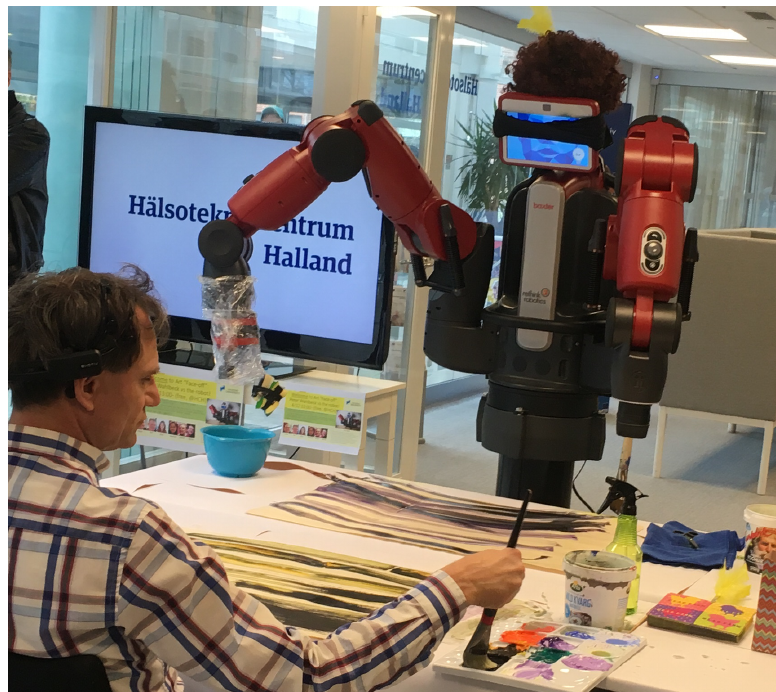
Figure 1. The basic concept of the current work is that we imagine robots can play a useful role in engaging with people emotionally and creatively in art therapy. The photo shows a robot painting with a person, which bases its artwork on the person’s emotions inferred using a Brain–Machine Interface. Used here with